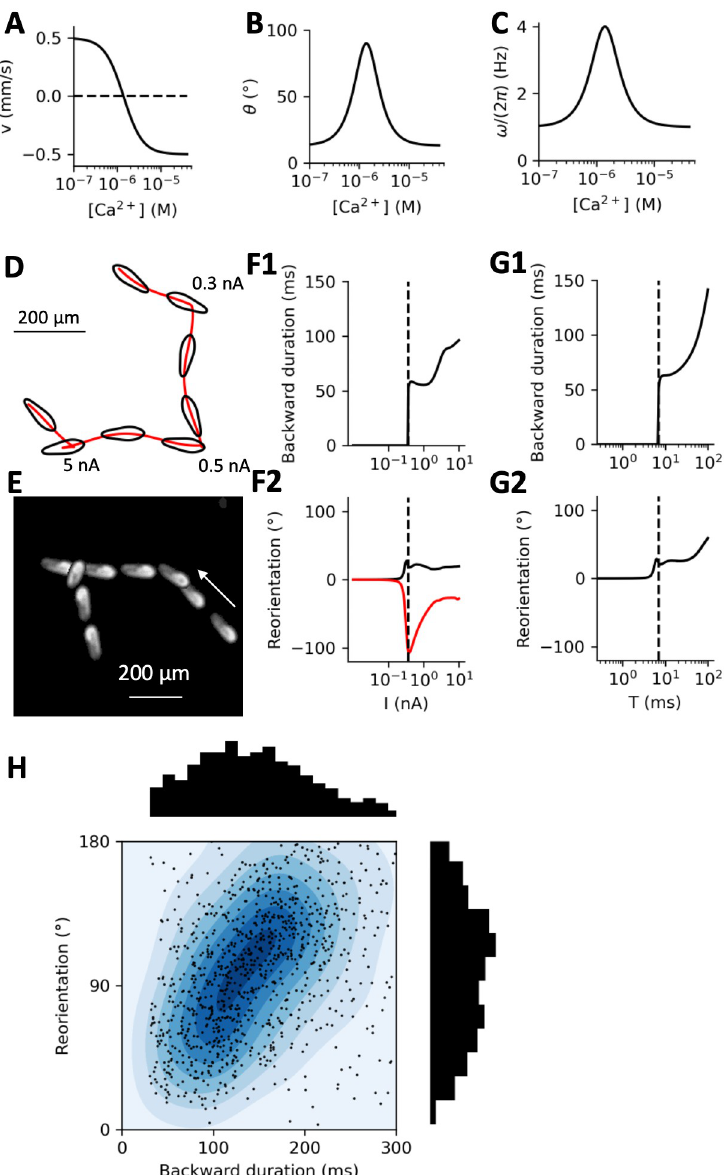
Fig 9. Simulation of the avoiding reaction. A, Velocity v as a function of intraciliary calcium concentration [Ca 2+ ] in the model. B, Angle θ of the rotation axis as a function of [Ca 2+ ] in the model. C, Spinning speed ω as a function of [Ca 2+ ] in the model. Angle and spinning speed increase at intermediate Ca 2+ concentration, as implied by the spherical model in Fig 8F and 8D, Simulated model trajectory with three 2 ms current pulse stimulations of increasing amplitude. Images are shown at 400 ms intervals. Without stimulation, the organism swims in spiral, with the oral groove facing the spiral axis. A very small stimulation deviates the trajectory. Stronger stimulations produce avoiding reactions, with backward swimming and turning. E, Example of an observed Paramecium trajectory showing a directional change without backward swimming (right), followed by a full avoiding reaction (left). Images are shown at 400 ms intervals, starting on the right. F, Backward swimming duration (F1) and reorientation angle (F2) as a function of current amplitude for 2 ms pulses. Red and black curves show results for the same model but different initial positions of the oral groove, differing by a quarter of a cycle. G, Backward swimming duration (G1) and reorientation angle (G2) as a function of current pulse duration T with 100 pA amplitude. H, Reorientation angle vs. backward swimming duration in n = 1138 spontaneous avoiding reactions of Paramecium, showing a positive correlation (linear regression r = 0.2, p � 10 − 11 ). About 15% of data points are not represented (larger angle or duration). Colors represent contour lines of the